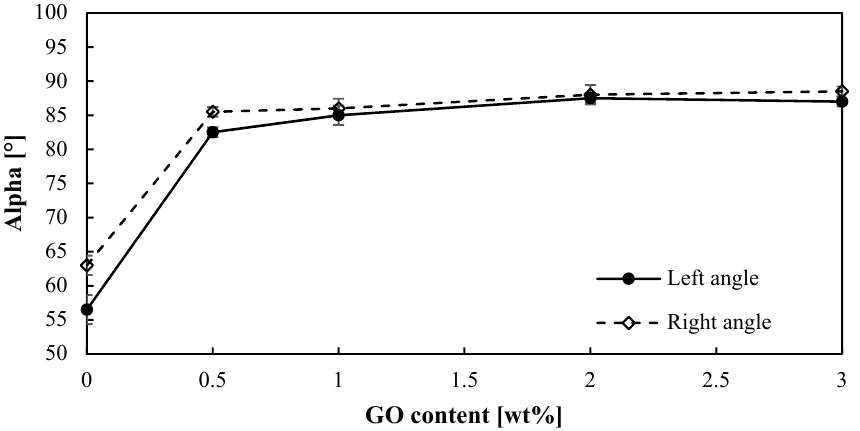
Figure 3. Contact angles (right and left) for the PBI-based membranes prepared.